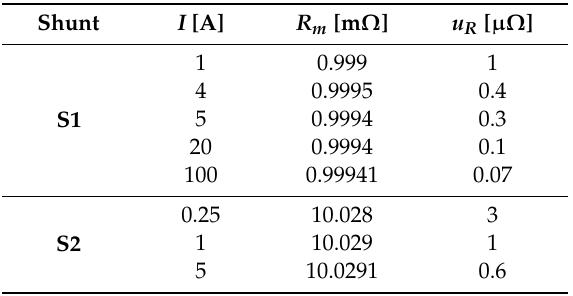
Table 5. Results of the characterization of the “shunts + DAQ” measurement chain.